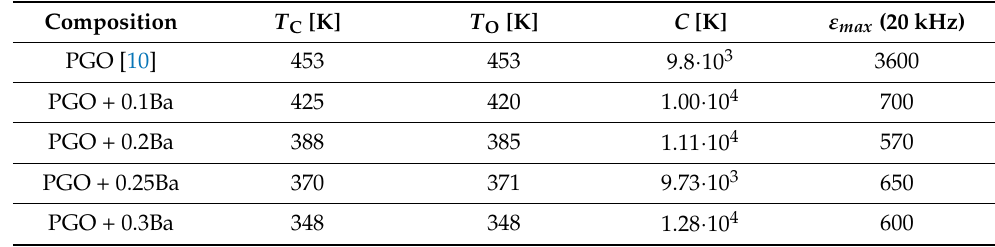
Table 1. A comparison of the values of Curie temperature T C , Curie–Weiss temperature T O , and Curie–Weiss constant C , and maximum value of electric permittivity ε max for the PGO + xBa (x = 0.1, 0.2, 0.25, and 0.3) as well as pure